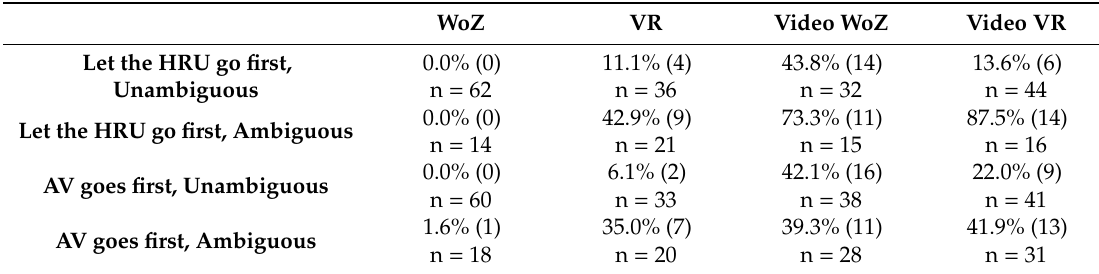
Table 8. Percentage and number of participants waited to press the button until the AV came to a complete standstill or passed by, for each setup.